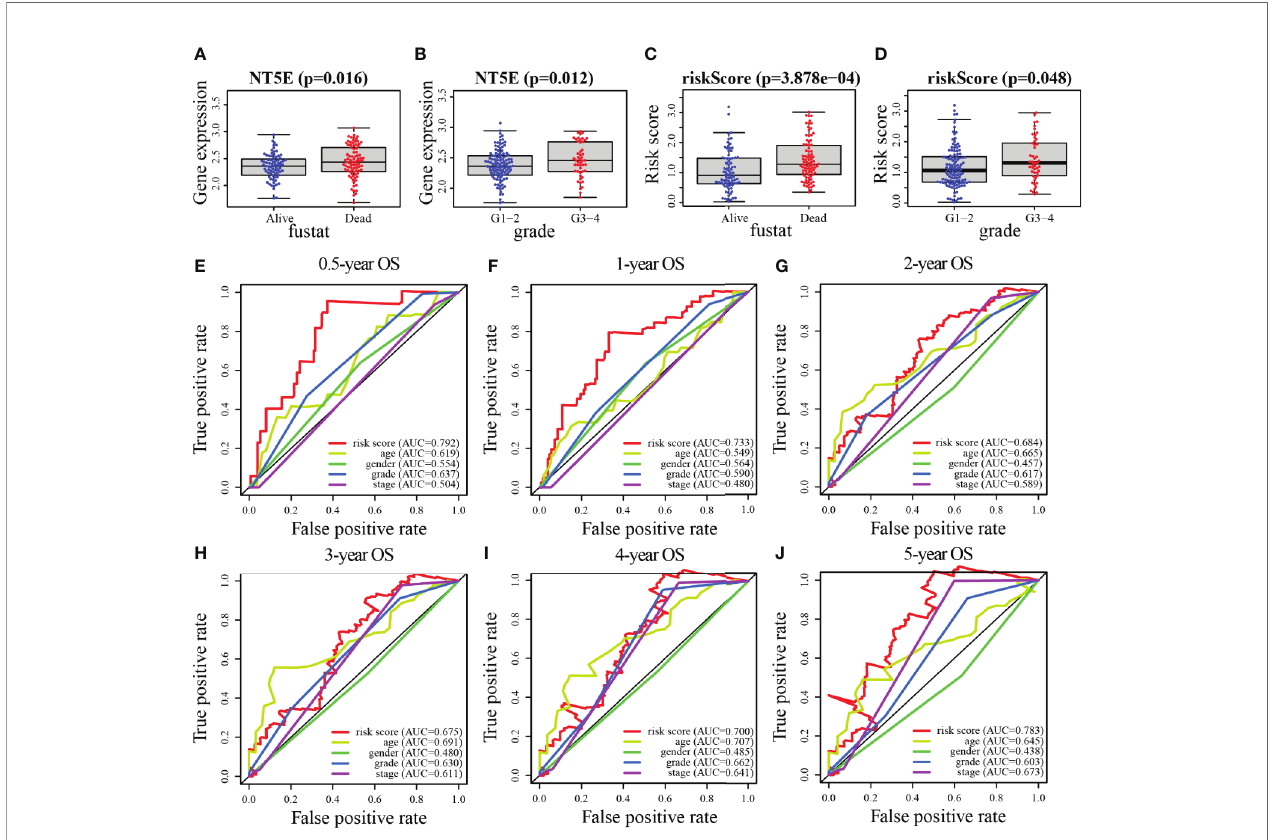
FIGURE 9 | Association between risk score and MRGs expression with clinical features of PC. (A, B) NT5E. (C, D) Risk score. (E – J) The ROC curve analyses of the prognostic variables in the TCGA cohort of 0.5, 1, 2, 3, 4, and 5 years,